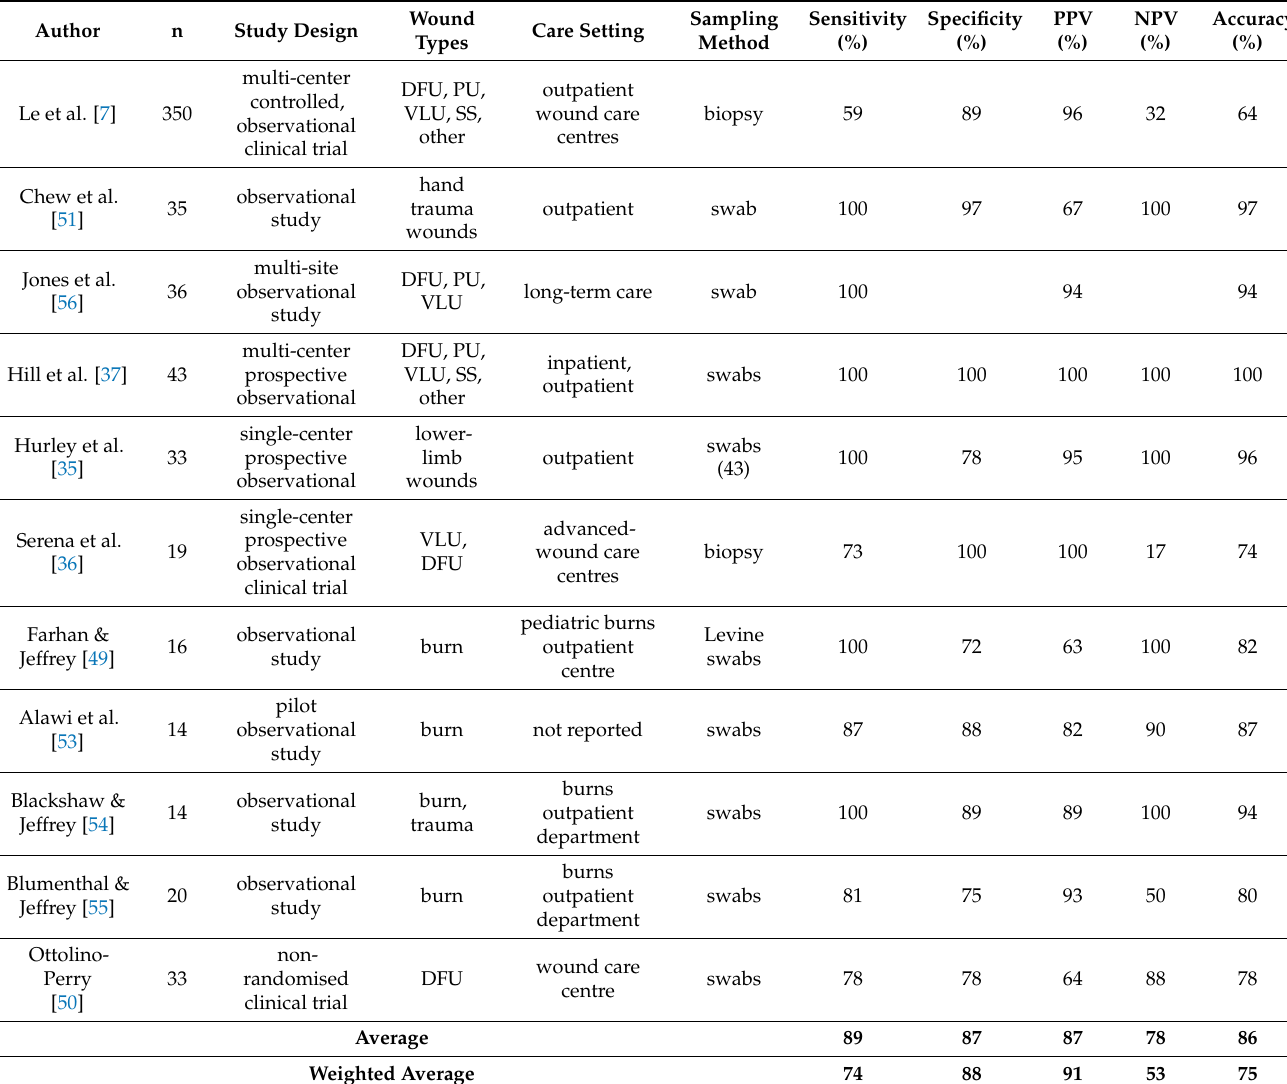
Table 2. A meta-analysis of publications reporting diagnostic accuracy measures of fluorescence imaging for detecting wound bacteria. Microbiology was used to confirm true bacterial loads. n, number of patients in the study; DFU, Diabetic Foot Ulcer; PU, Pressure Ulcer; VLU, Venous Leg Ulcer; SS, Surgical Site; PPV, Positive Predictive Value; NPV, Negative Predictive